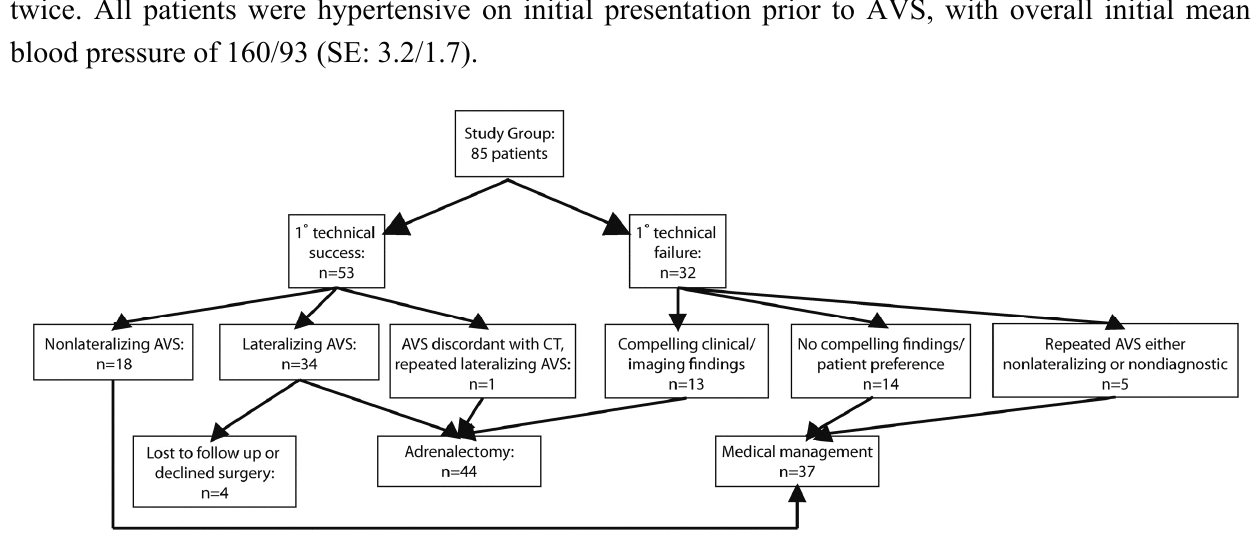
Figure 1. Flow diagram illustrating study patients. There were 85 patients included in the study. Workup and outcomes are